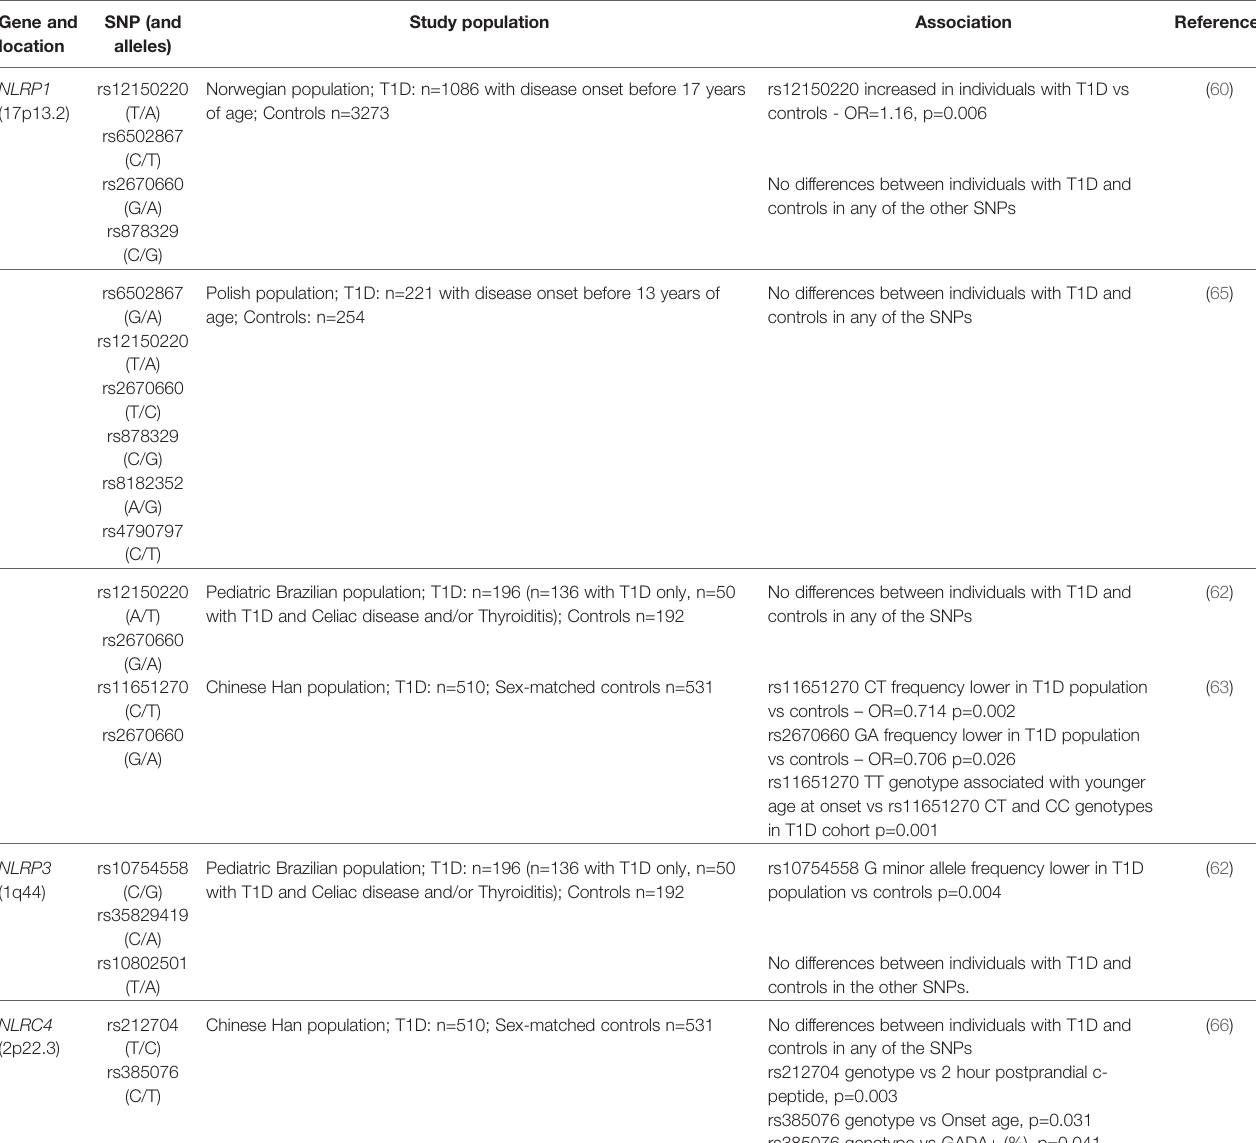
TABLE 1 | SNPs in in fl ammasome genes that have been investigated for associations with autoimmune diabetes in humans. Gene and SNP (and location